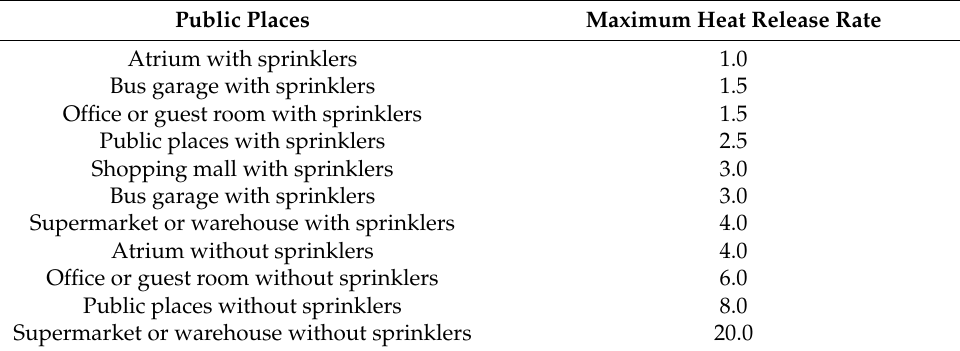
Table 5. Maximum heat release rates of a fire source in different public places. Public